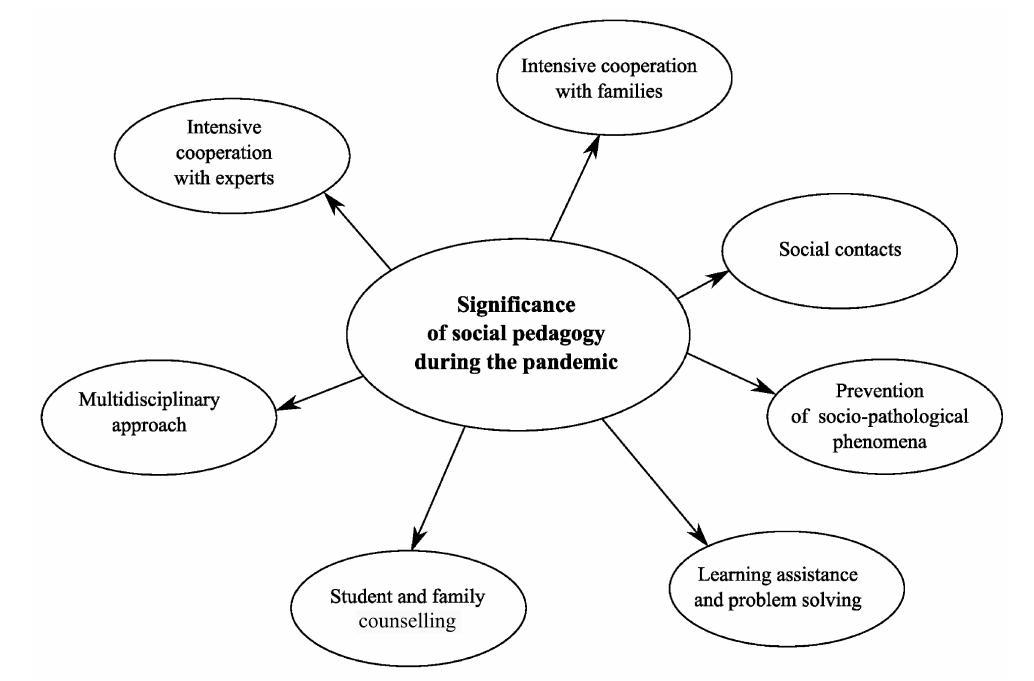
Figure 1. The significance of social pedagogues in Slovakia during the pandemic (Source: